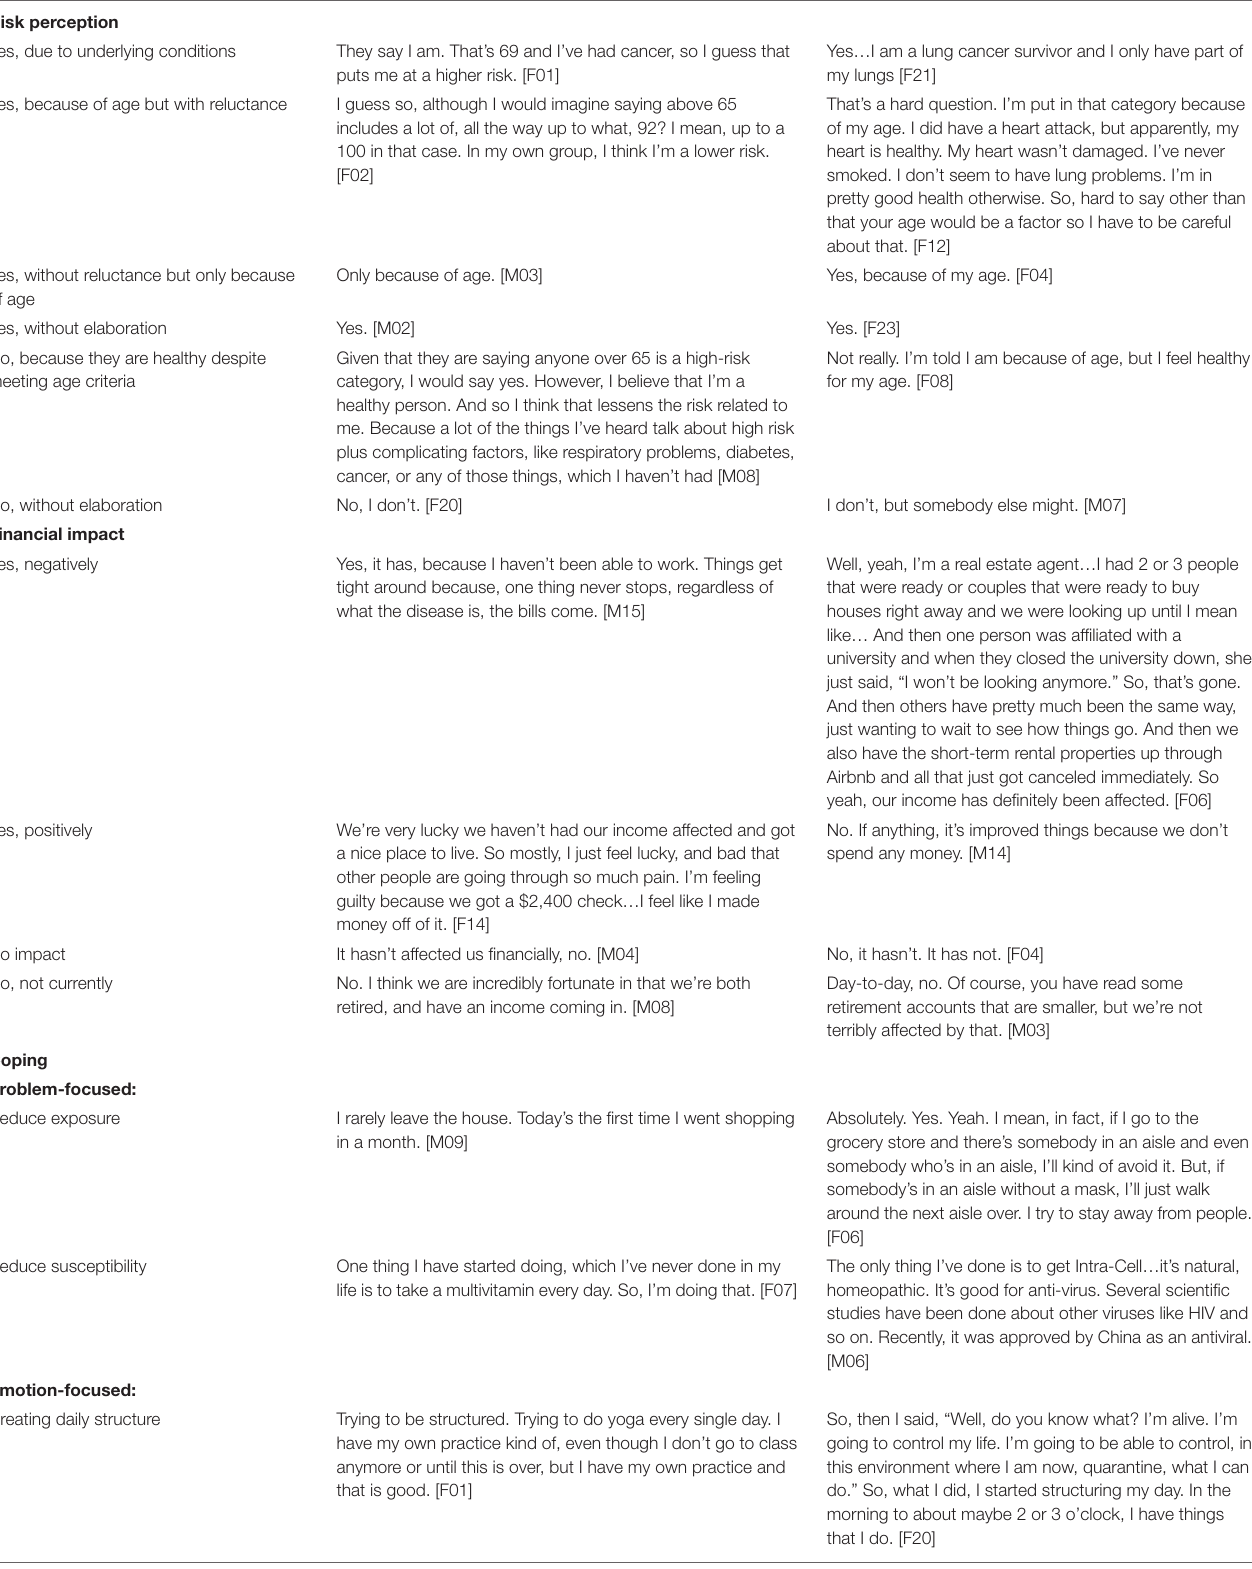
TABLE 3 | Exemplar quotes. Risk